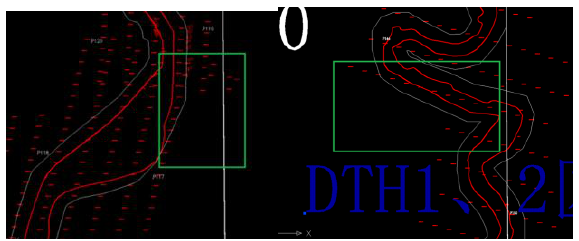
Figure 2 . The route coverage area does not meet